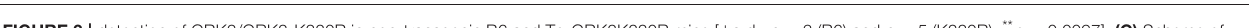
FIGURE 3 | detection of GRK2/GRK2-K220R in non-transgenic B6 and Tg-GRK2K220R mice [ ± s.d., n = 3 (B6) and n = 5 (K220R); ** p = 0.0097]. (C) Scheme of expression plasmid used for generation of Tg-RKIP and Tg-GRK2K220R mice with myocardium-specific expression of RKIP and GRK2-K220R under control of the alpha-MHC promoter. (D) Left ventricular ejection fraction (EF) of different eight-months-old transgenic mouse lines compared to age-matched, non-transgenic B6 controls ( ± s.d., n = 5; *** p < 0.001, and * p < 0.05 vs. B6; Dunnett’s test). (E) Left ventricular end-diastolic diameter (left), left ventricular end-systolic diameter (middle), and interventricular septal thickness (right) of B6, Tg-RKIP2, Tg-RKIP3, and Tg-GRK2K220R mice ( ± s.d., n = 5; *** p < 0.001 vs. B6; Dunnett’s test). (F) Heart-to-body weight ratio of different transgenic lines compared to non-transgenic B6 controls ( ± s.d.; n = 6; *** p < 0.001 vs. B6; Dunnett’s test). (G) Histological assessment of cardiac sections from a Tg-RKIP2 mouse, a non-transgenic B6 mouse and a Tg-GRK2K220R mouse. Sections were stained with hematoxylin-eosin (H&E) and are representative of six mice/group (bar: 2mm). (H,I) Cardiac fibrosis was determined by picrosirius red staining (H) , and myocardial necrosis was assessed by von Kossa stain (I) of Tg-RKIP2 and Tg-GRK2K220R mice compared to non-transgenic B6 mice. Left panels show quantitative data evaluation ( ± s.d.; n = 6 mice/group; *** p < 0.001 vs. B6; Dunnett’s test), and right panels show representative histological sections (bar: 40 µ m). See also Supplementary Figures 3A,B